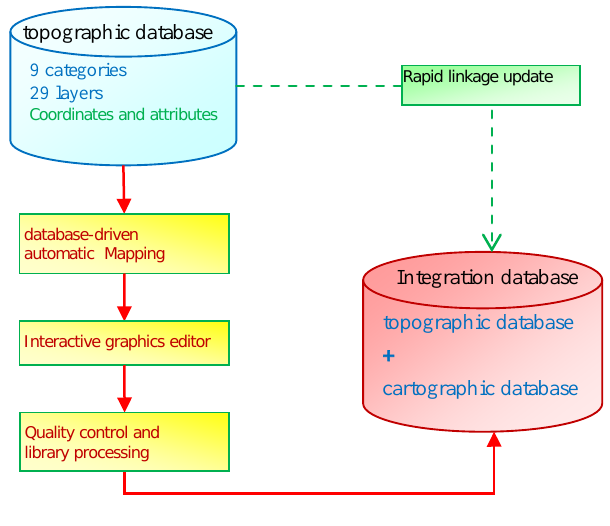
Figure 4. The technology methods and steps of integration cartographic database